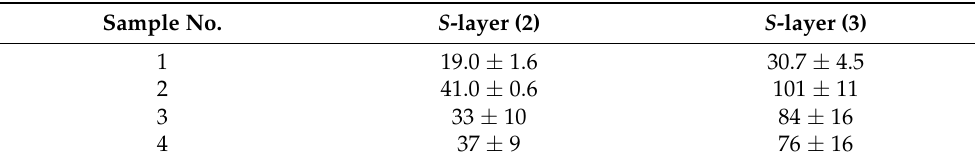
Table 2. Due to the influence of surface effect on the surface layer, the positron diffusion lengths in this layer are not considered here. The positron diffusion lengths of sample No.1 are shorter than that of other samples in the corresponding layers, because the positrons are captured by defects and their diffusion is hindered. According to Equation (4), the positron diffusion length is inversely proportional to the defect concentration. In the layer (2), the small positron diffusion length in the 850 ◦ C sample indicates a large vacancy defect concentration, while the large positron diffusion length in the 1000 ◦ C sample indicates a small vacancy defect concentration. Our fitting results are reasonable and consistent with the above analysis. The difference of positron diffusion lengths between No.3 and No.4 samples is not obvious, owing to the small difference of the vacancy type defects in the two samples. Table 2. The positron diffusion lengths (nm) of CVD-W samples after irradiated with different conditions. Sample No. S -layer (2) S -layer (3) 1 19.0 ±